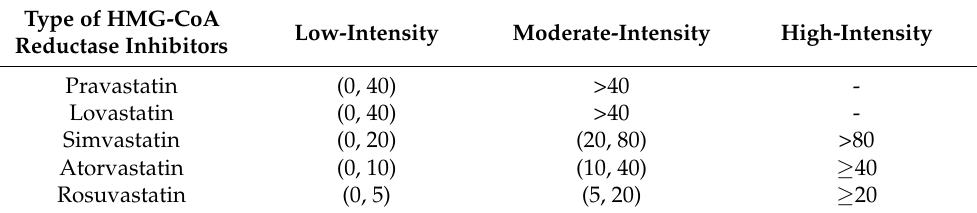
Table 7. Bin values for medications belong to hydroxymethylglutaryl-CoA (HMG-CoA)